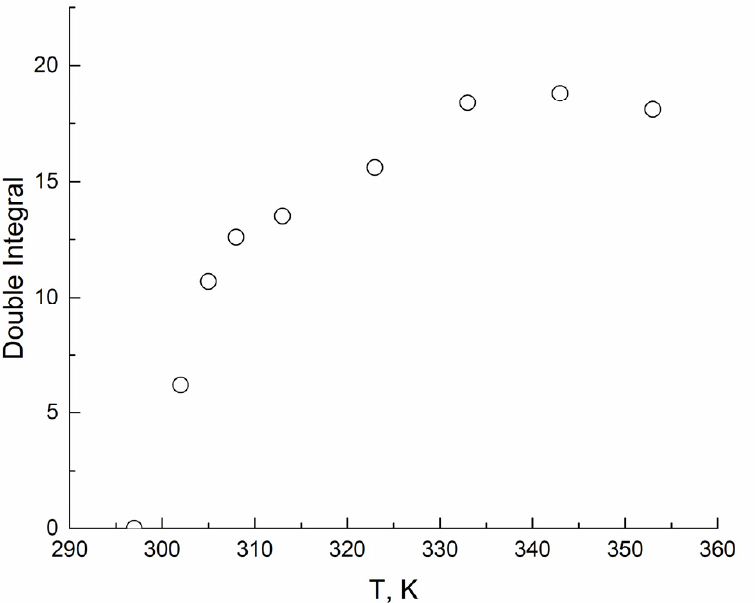
Figure A6. Change of double integral of EPR spectra of TEMPO in PNIPAM aqueous solution in the presence of Cu(II) vs. temperature.